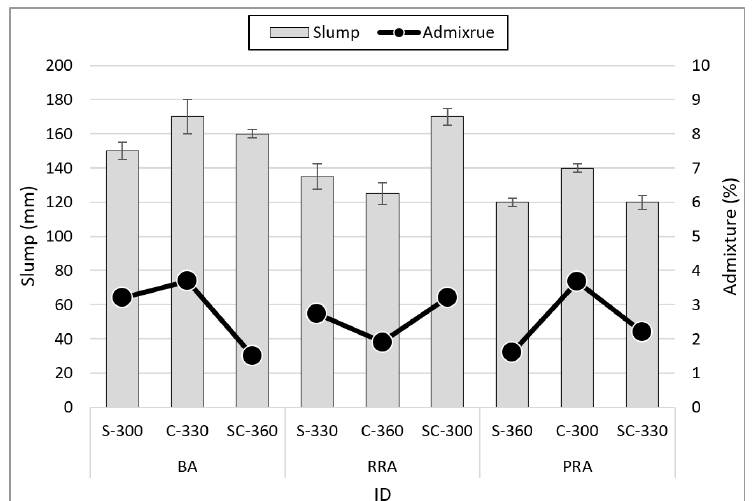
Figure 6. Slump of fresh